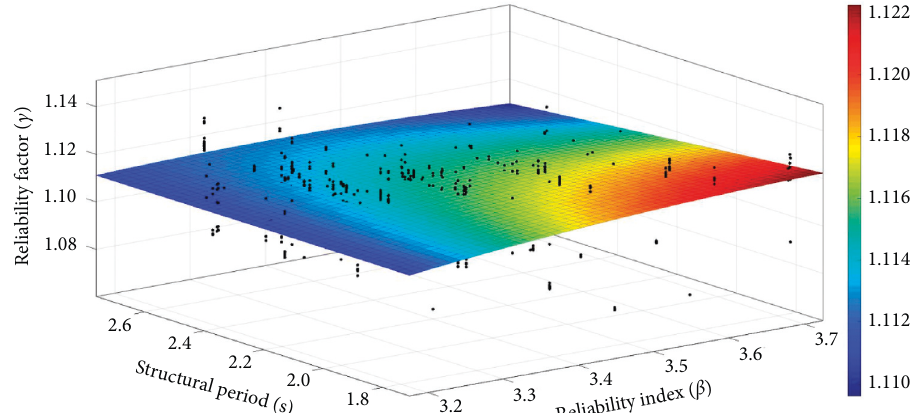
Figure 5: Demand factor vs reliability index and structural vibration period.